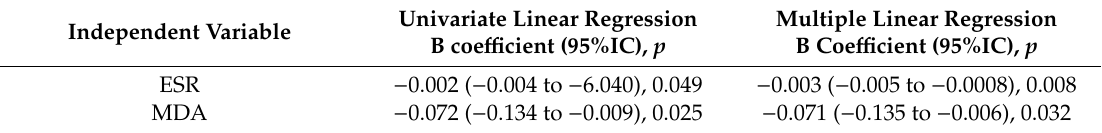
Table 5. Independent determinants of